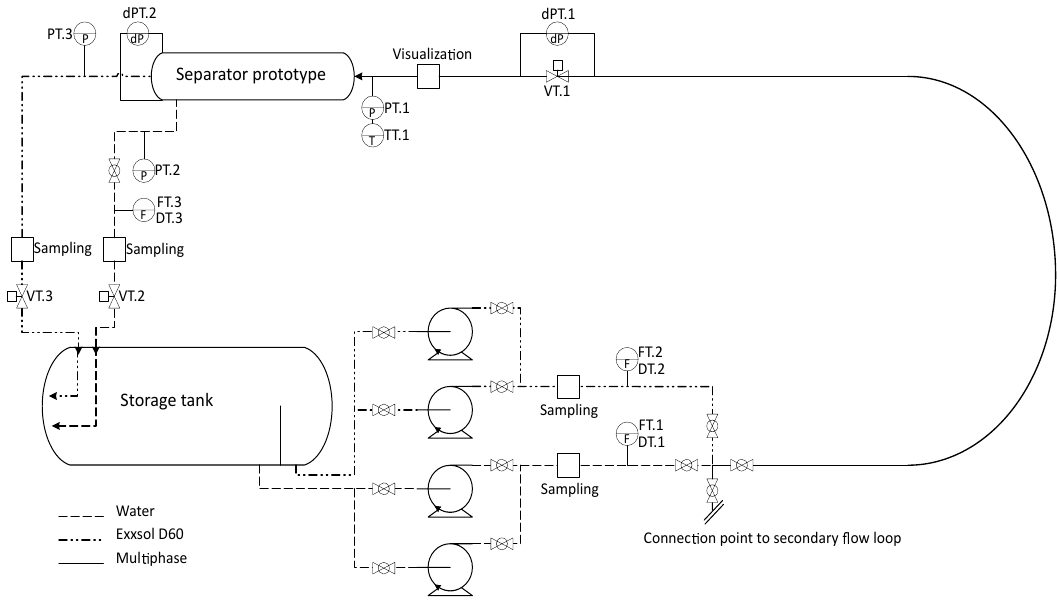
Figure 2. Lab facility piping and instrumentation diagram